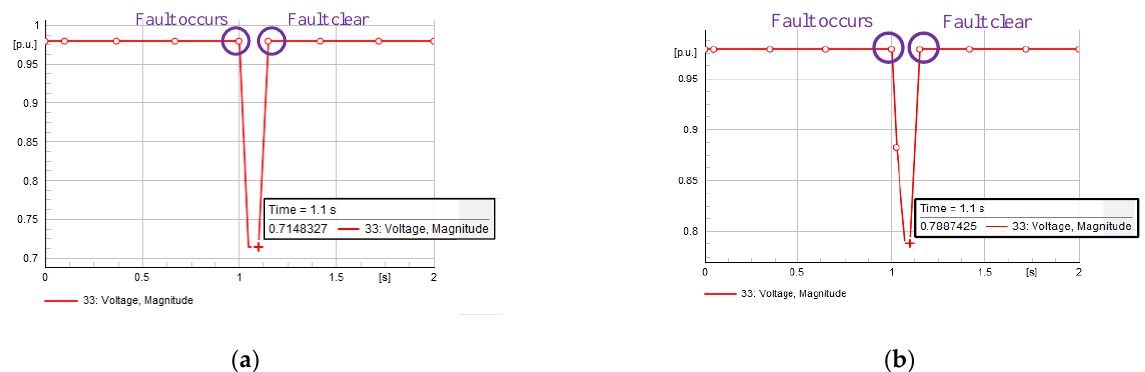
Figure 17. Fault conditions: ( a ) 463 kW capacity at bus 33 and 127 kW capacity at bus 15; ( b ) 453 kW capacity at bus 32 and 237 kW capacity at bus 14.